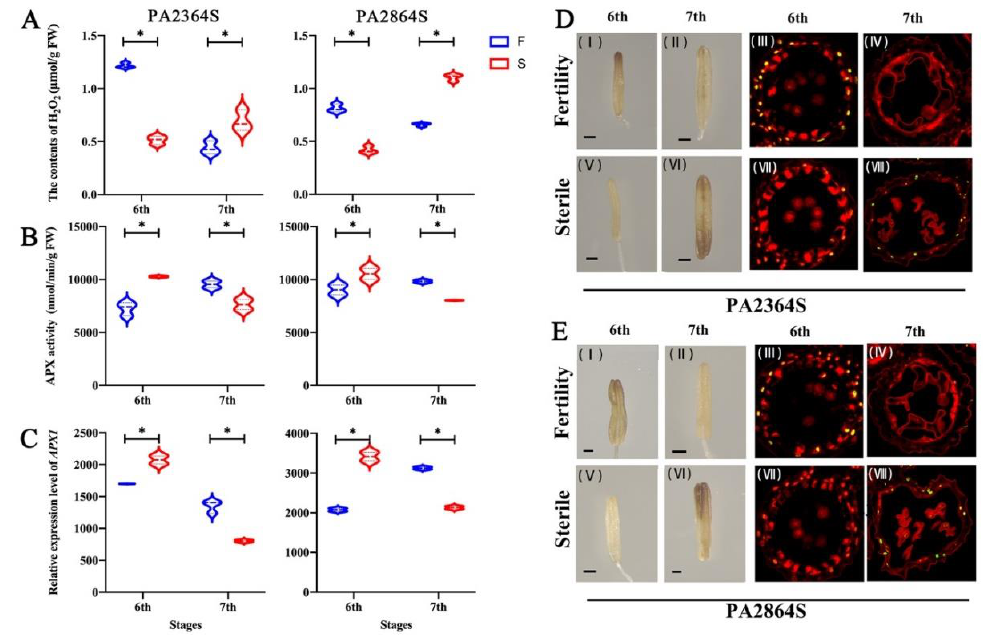
Figure 10. Effect of ROS and APX on the PCD process in the anther tapetum. ( A ) The content of H 2 O 2 in PA2364S and PA2864S. ( B ) The APX activity in PA2364S and PA2864S. ( C ) The relative expression level of APX1 in PA2364S and PA2864S. ( D ) DAB staining and transferase mediated dUTP nick end labeling (TUNEL) assay of PA2364S ( D ) and PA2864S ( E ) anthers. Sterisks indicate significant differences revealed by Student’s t -test at p < 0.05 (*).